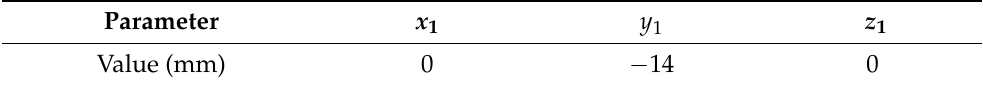
Table 3. Parameters of the initial position of the CAD mechanical design.